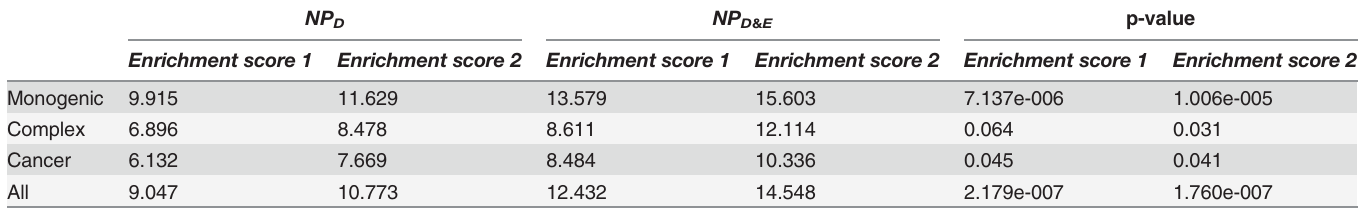
Table 8. Statistics of the performance (the average values of enrichment score) with disease as a unit to detect disease genes of 83 diseases veri fi ed after 2008. Signi fi cances (p-value) between the results of NP D and NP D & E were calculated by the one tailed student ’ s t -test. NP D NP D & E